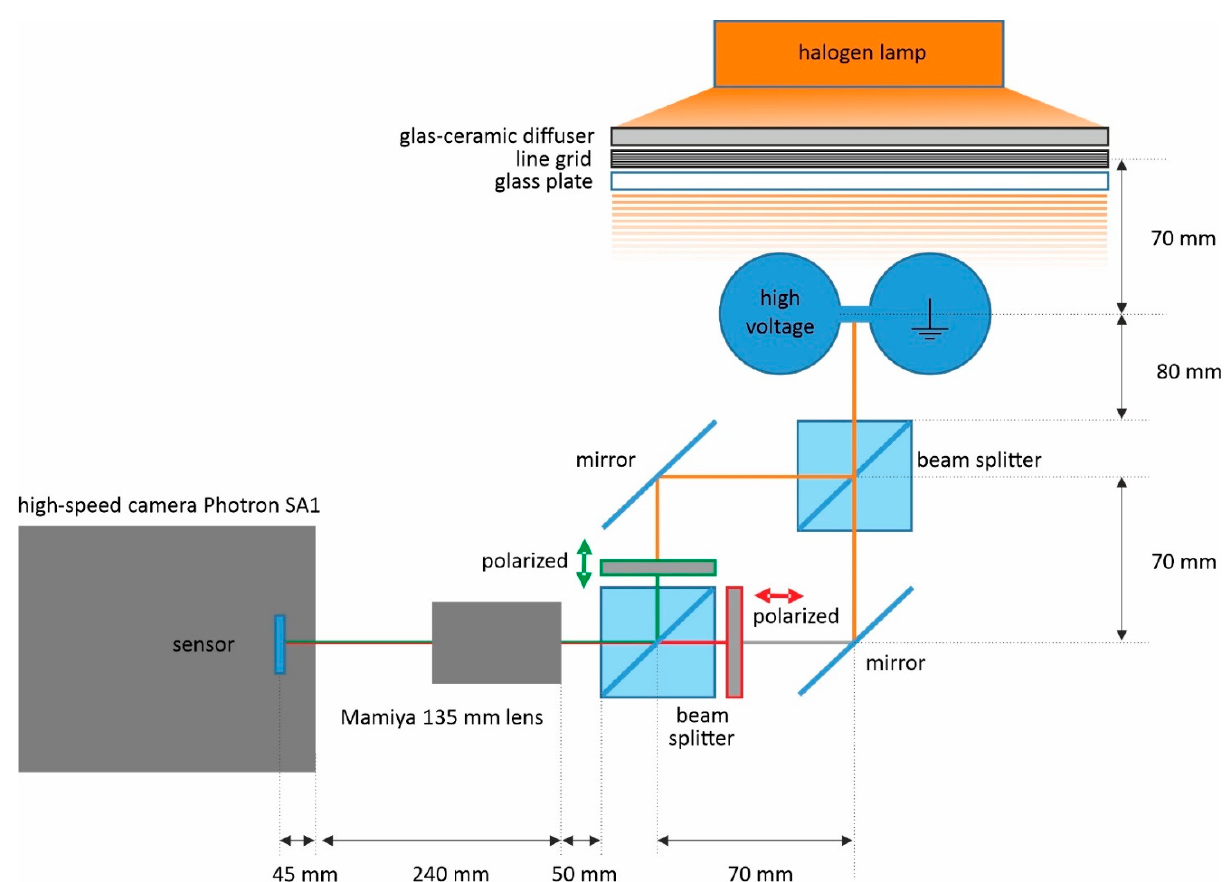
Figure 1. Mach–Zehnder-like interferometer set-up for instantaneous imaging of horizontal and vertical polarization of a fringe projection through a floating water bridge.